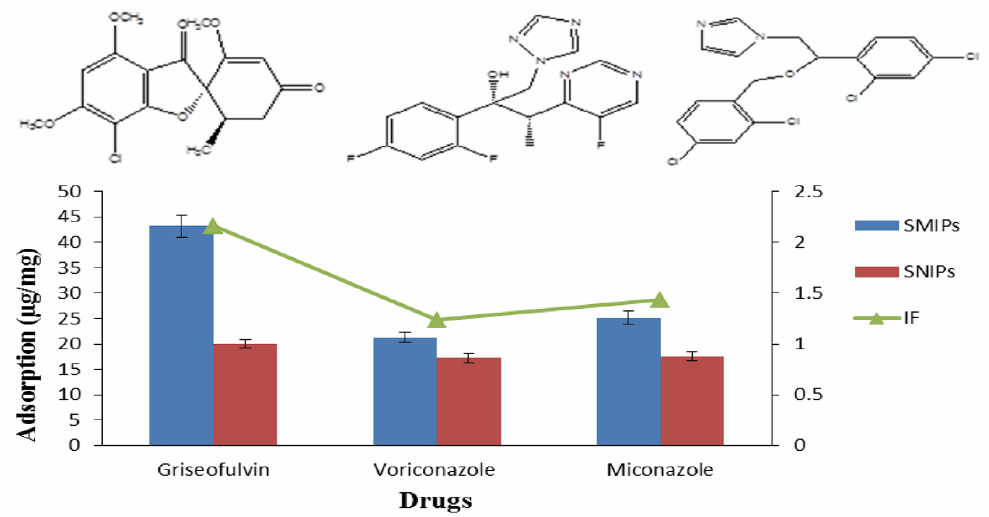
Figure 4. Selectivity of surface molecularly imprinted polymers (SMIPs) and surface non imprinted polymers (SNIPs).